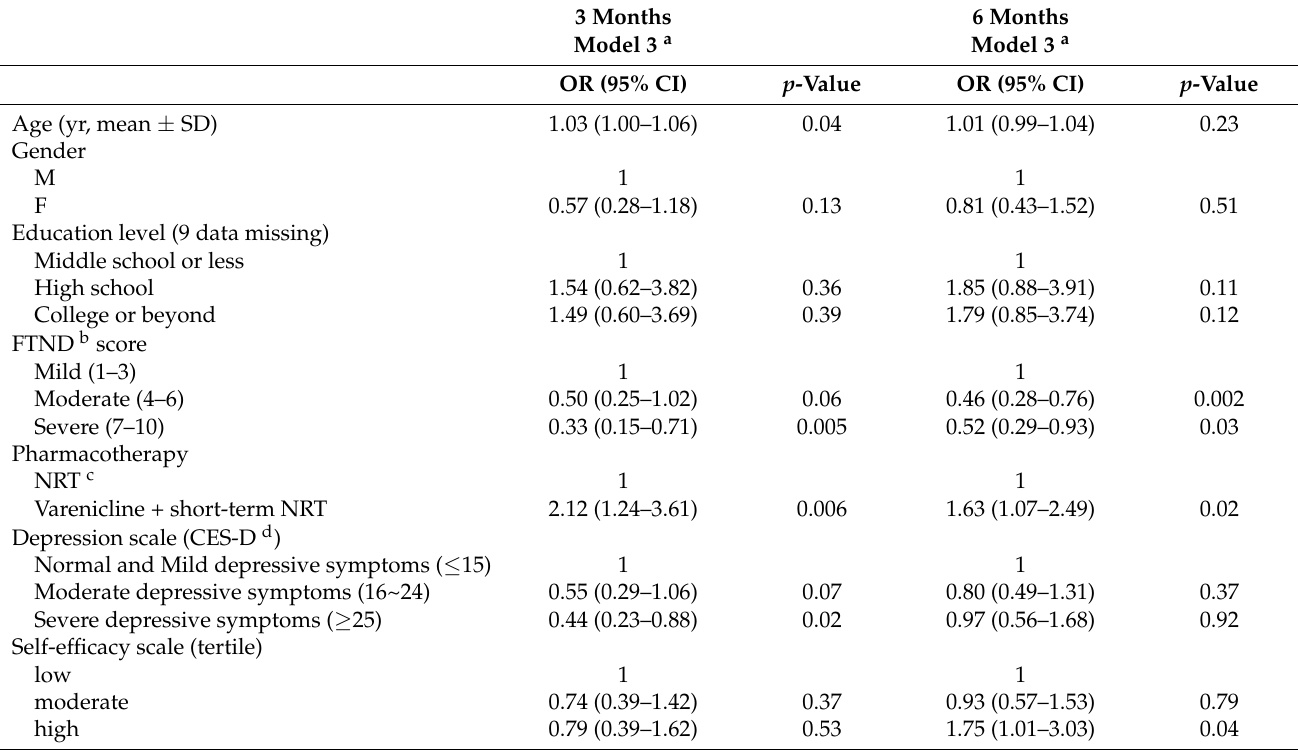
Table 6. Multivariable logistic regression analysis of factors associated with smoking